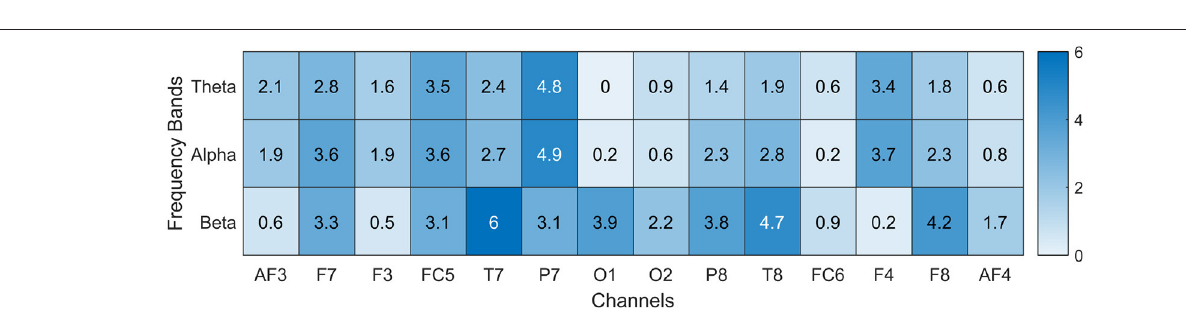
Frontiers in Neuroscience |